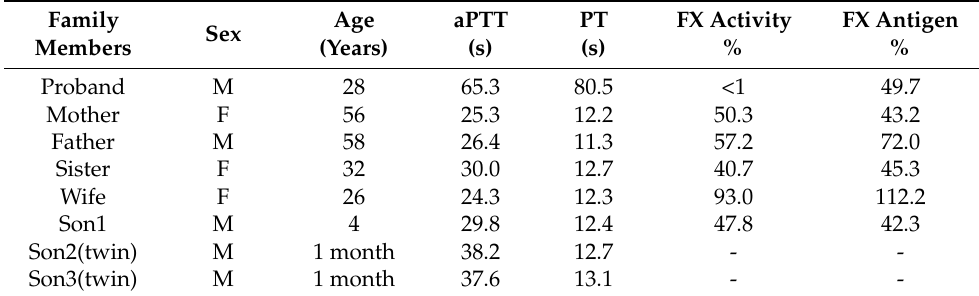
Table 1. Demographics and coagulation parameters of the proband and family members.